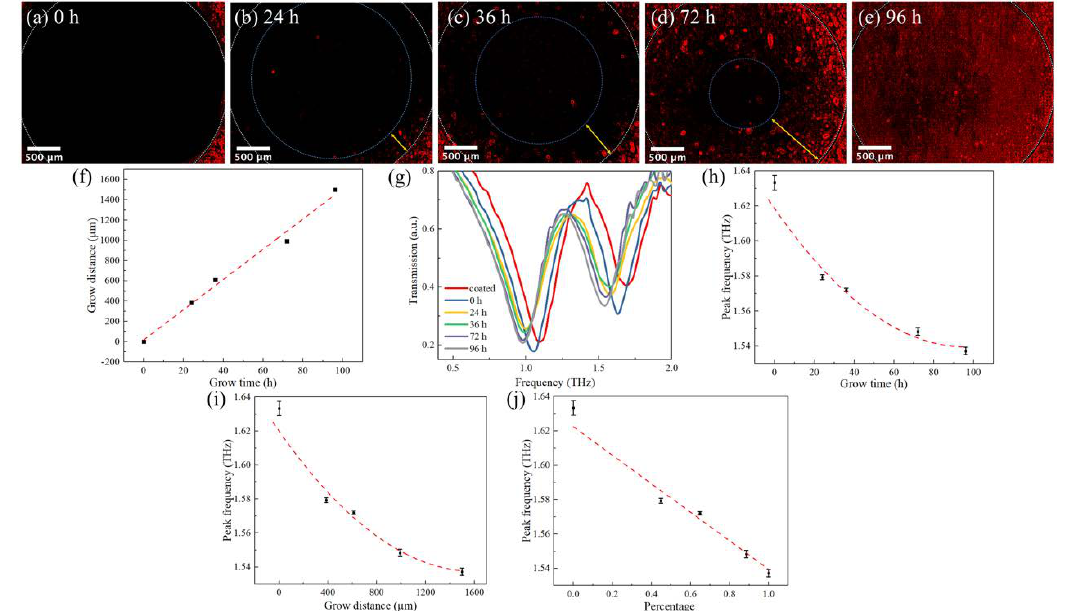
Figure 6. The cell growing behavior on the metamaterial biosensor. ( a – e ) Fluorescence pictures of the biosensor removing the PDMS barrier sheet for 0, 24, 36, 72, and 96 h. ( f ) The dependence of growth distance on time. ( g ) The transmission spectra of biosensor removing the PDMS barrier sheet for 0, 24, 36, 72, and 96 h. ( h ) The dependence of peak frequency extracted from ( g ) on time. ( i ) The dependence of peak frequency on growth distance. ( j ) The dependence of peak frequency on area ratios of cells and the inner circle.